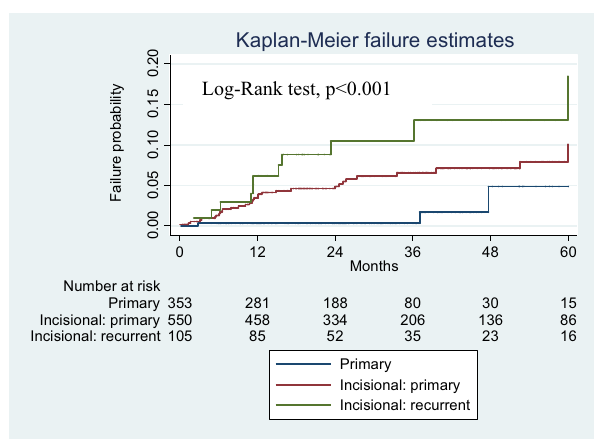
Figure 2. Kaplan–Meier survival curve for hernia recurrence; comparison for type of hernia (PH; primary IH; recurrent IH), Log rank, p < 0.001. Recurrence is defined as failure